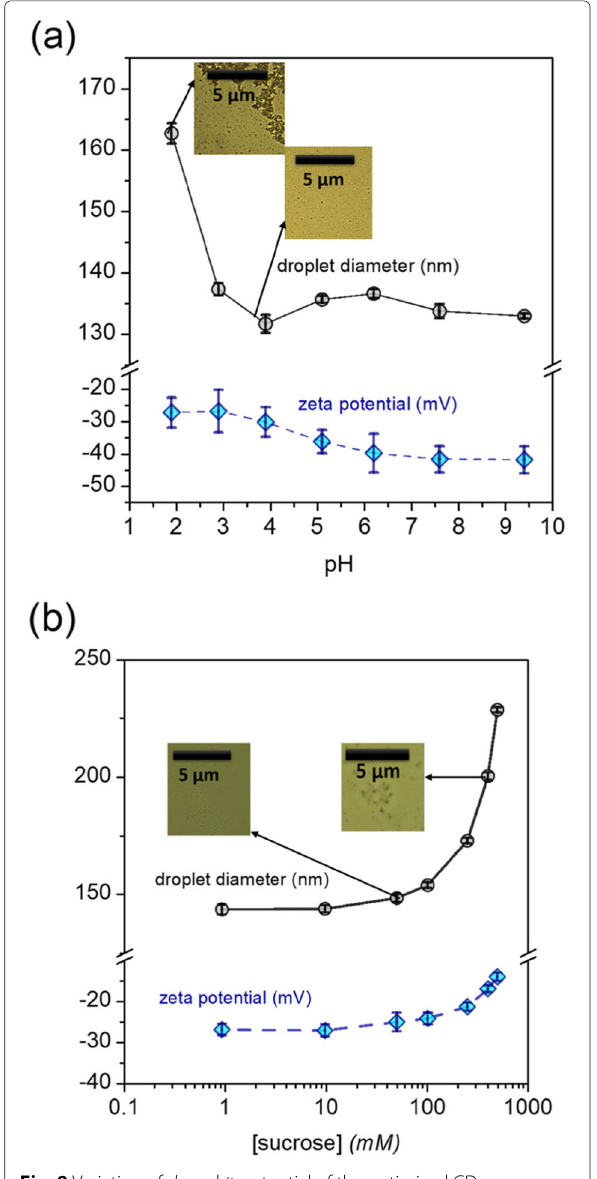
Fig. 8 Variation of d z and ζ potential of the optimized CD CBD nanoemulsion as a function of: a the pH; b increasing sucrose concentration. (Inset) optical micrographs of the optimized nanoemulsion a at pH 3.8 and pH 1.6; b at two different sucrose